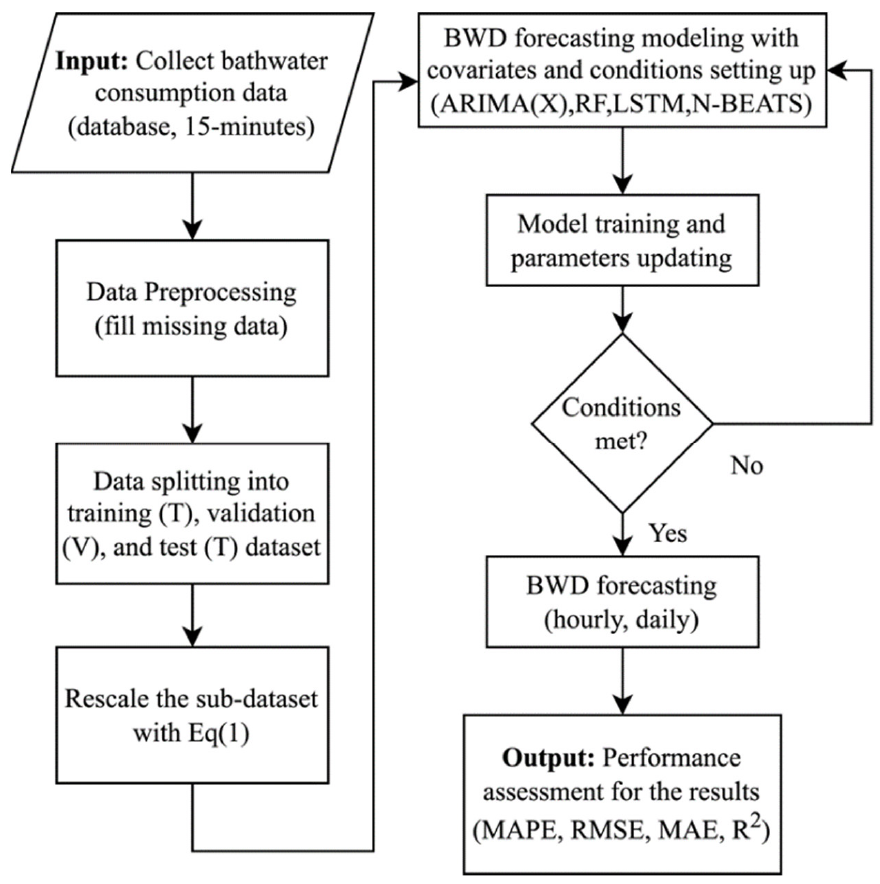
Figure 1. Diagram illustration of BWD forecasting and performance assessment.